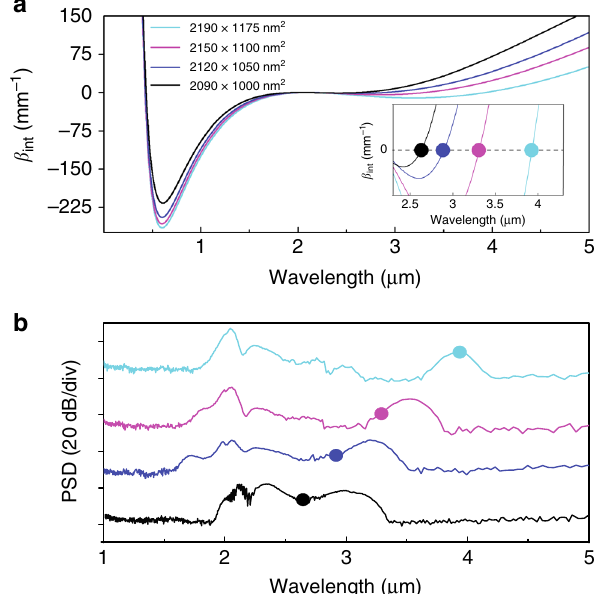
Fig. 3 Dispersive wave generation. a Integrated dispersion for the four waveguides under test. The inset shows expected mid-IR phase matching points. b Experimental spectra recorded at an estimated average coupled power of 13.6 mW, for the four different waveguides under test (same color convention as for ( a )). Points show the expected mid-IR phase matching